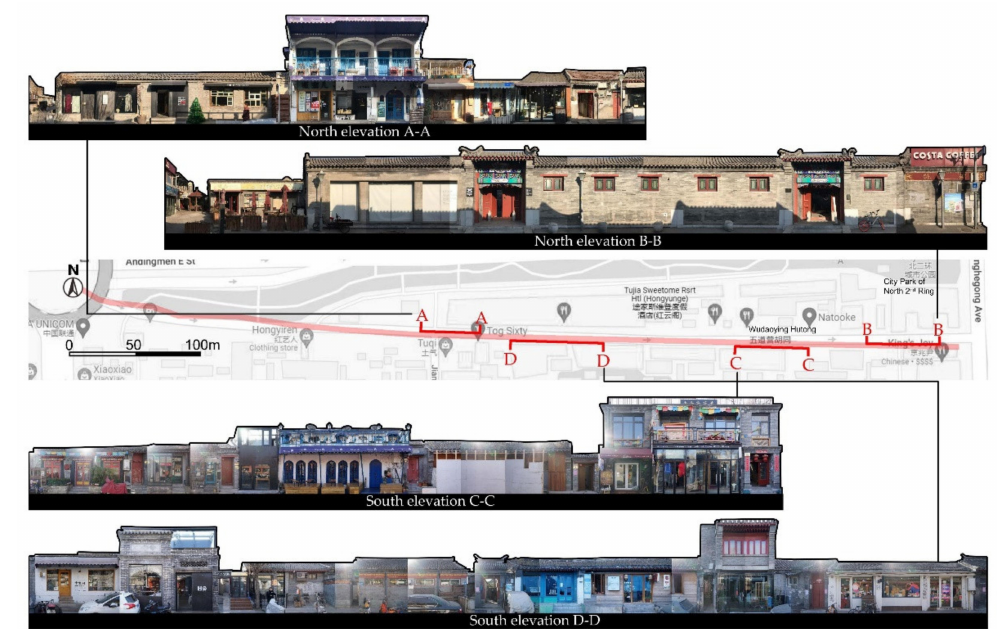
Figure 4. Video clips of the northern and southern facades of Wudaoying